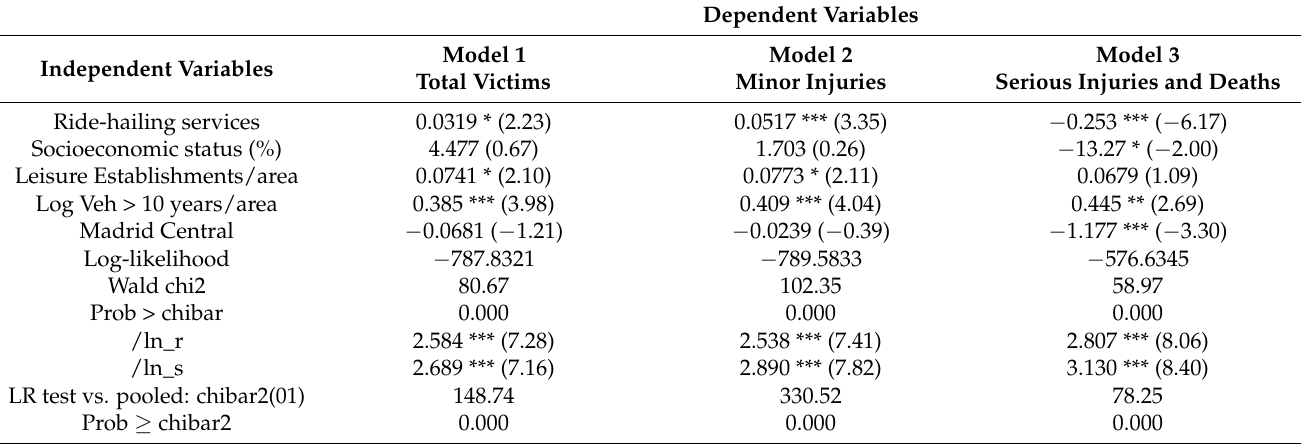
Table 6. Results of the estimated model (z-statistics in parentheses). Source, own research. Dependent